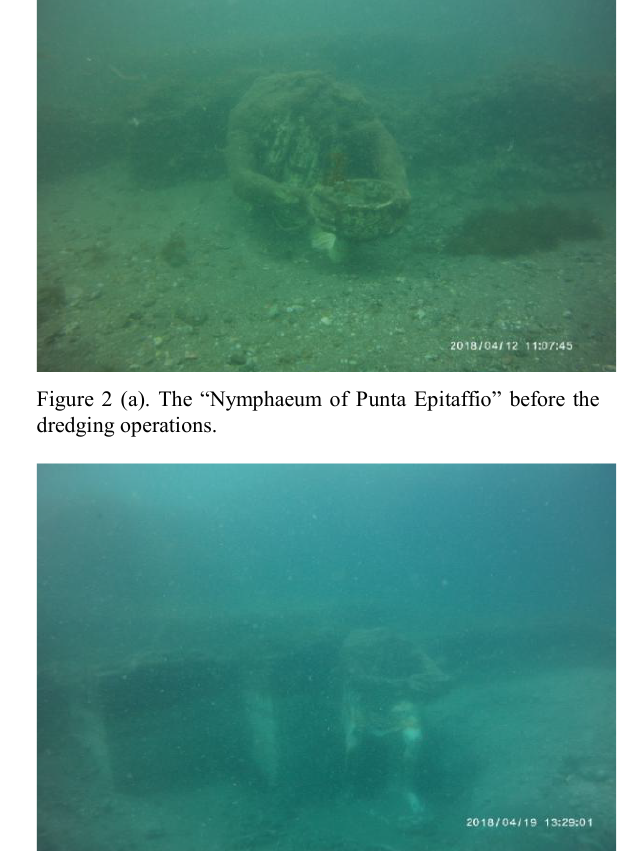
Figure 2 (b). The “Nymphaeum of Punta Epitaffio” after the dredging